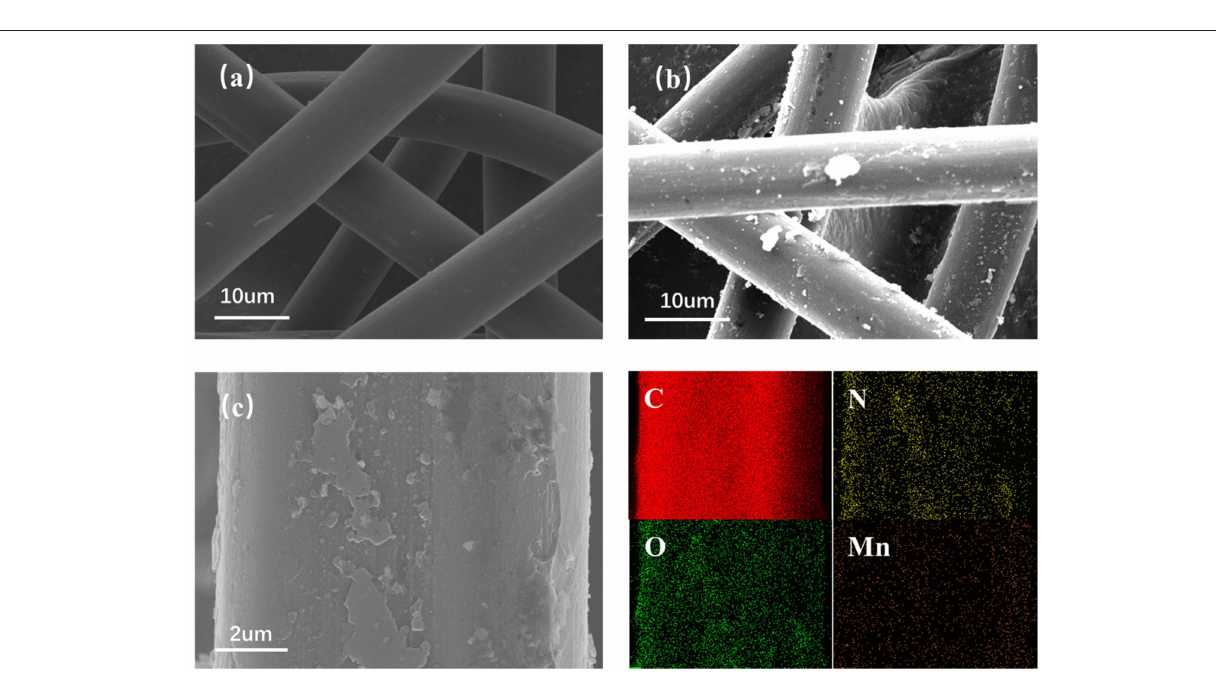
corresponding to the typical “C-C/C = C” (283.63 eV), “C = N/C- N/C-O” (285.29 eV), and “C = O” (287.07.8 eV) bonds. The fitted peaks of N 1 s at 398.04 and 399 eV were attributable to “N- C” and “N-Mn,” respectively. The Mn 2p spectra demonstrated obvious peaks at 641.39, 645.25, and 652.92 eV, assigned to Mn 2p 3 / 2 , satellite state Mn, and Mn 2p 1 / 2 , which